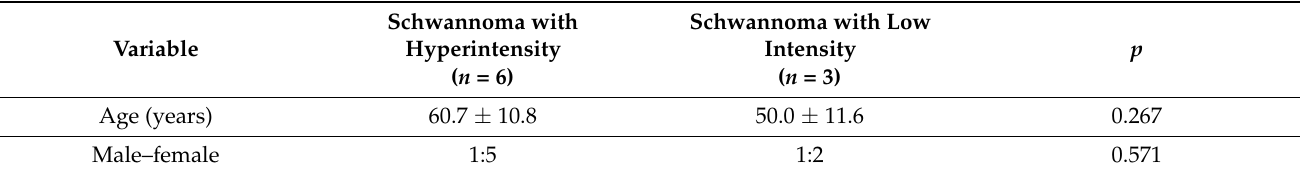
Table 2. Comparison of demographic and clinical characteristics and imaging findings between patients with schwannomas with T2 hyperintensity and low